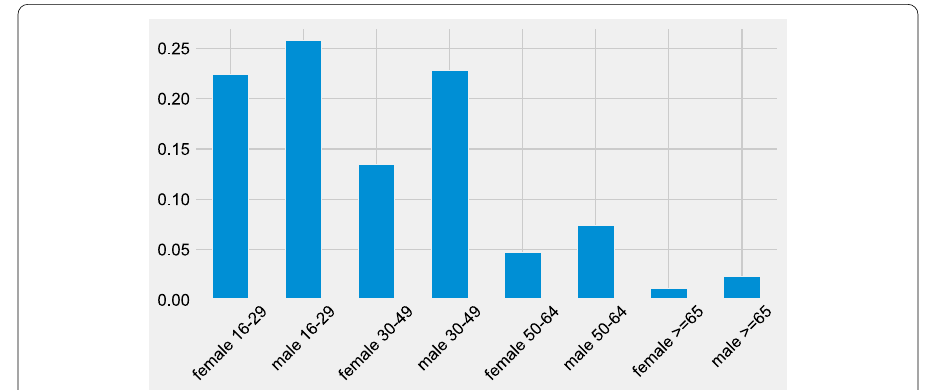
Fig. 13 Distribution of Twitter populations by age and gender during 2019 Argentina